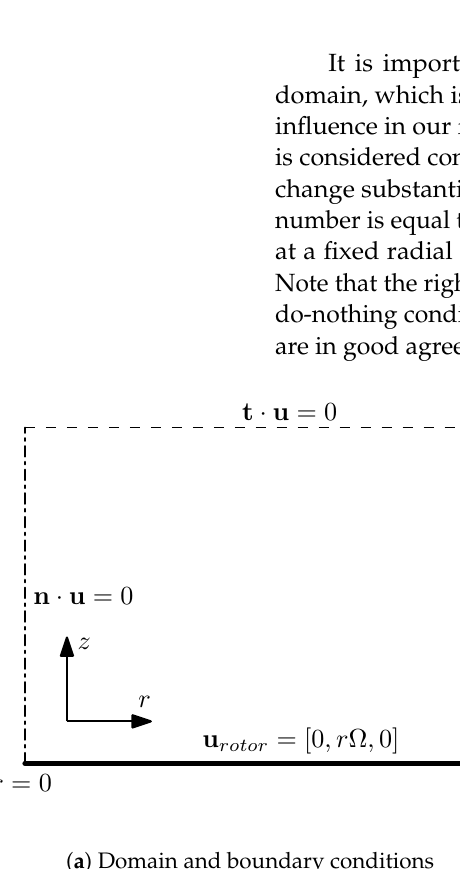
Figure 6. Von Kármán rotating disk problem benchmark and results. Numerical results are monitored at a fixed radial position, r / r max = 0.4.